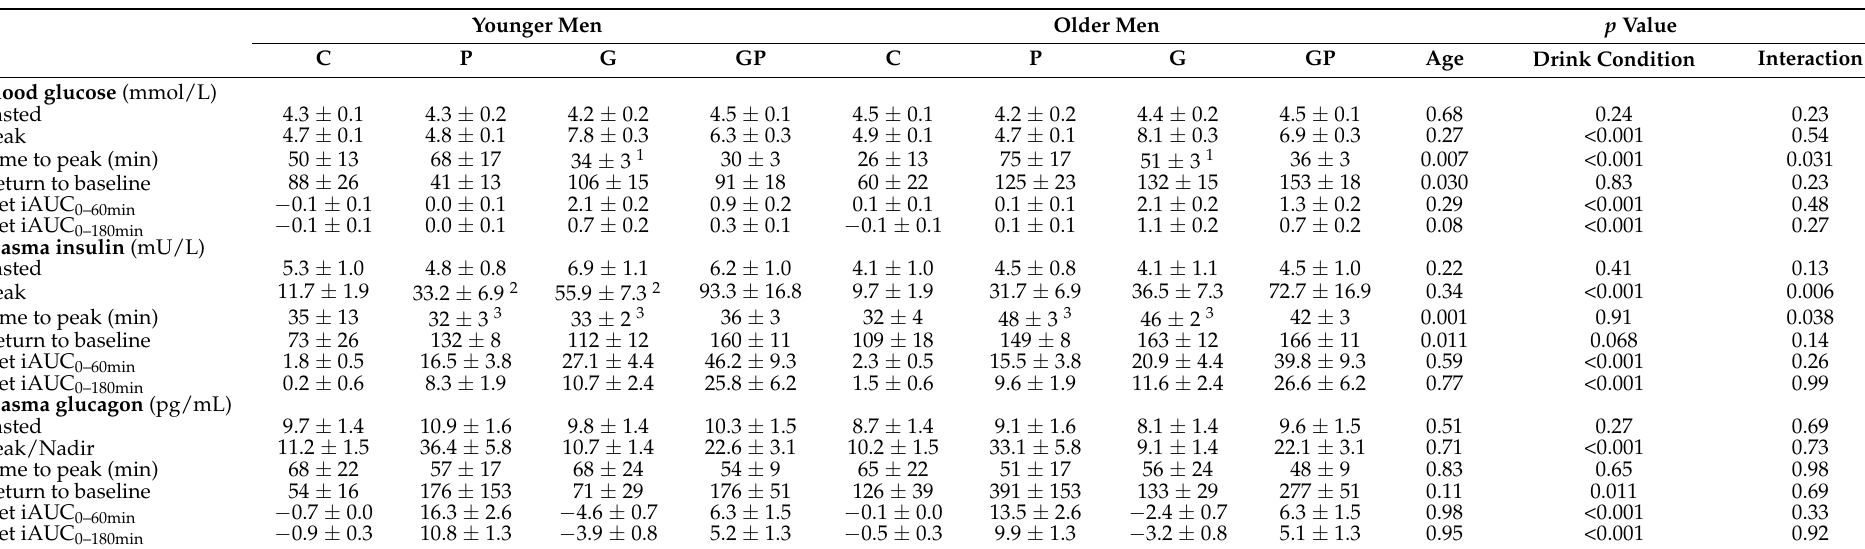
Table 1. Blood glucose, plasma insulin and plasma glucagon concentrations following control drink (C), 30 g whey protein drink (P), 30 g glucose drink (G) and 30 g whey protein plus 30 g glucose drink (GP)